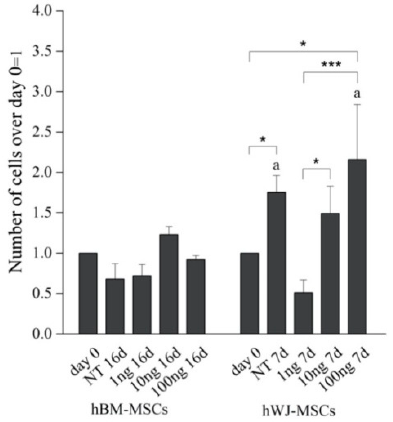
Figure 2. Proliferation rate of hBM-MSCs and hWJ-MSCs with the human Growth Differentiation Factor 5 (hGDF-5) dose-dependent effect. The proliferation rate was calculated over different culture time points and for both untreated cells and hGDF-5 treated cells. Statistically significant differences are shown as * = p ≤ 0.05; ** = p ≤ 0.01; *** = p ≤ 0.005; a = p ≤ 0.05 compared to hBM-MSCs (NT 7d hWJ-MSCs vs. NT 16d hBM-MSCs; 100 ng 7 d hWJ-MSCs vs. 100 ng 16 d hBM-MSCs); n = 3. (NT = untreated cells; 1 ng = 1 ng/mL of hGDF-5; 10 ng = 10 ng/mL of hGDF-5; 100 ng = 100 ng/mL of hGDF-5; d = days). Compared to tenoblasts, whose nucleus is ovoid (nuclei length / width ratio < 1.5), the overall tenocytes shape and their nucleus appears elongated with a nuclei length / width ratio > 1.7 (Figure 3a) [61,62]. Therefore, hBM-MSCs phenotype commitment was evaluated by nuclear aspect ratio evolution (length / width: L / W) determined at Day 1, 8 and 16. hBM-MSCs also showed a specific alignment and shape modification (tenoblast-like) with an L / W ratio ≥ 1.5 when 100 ng /